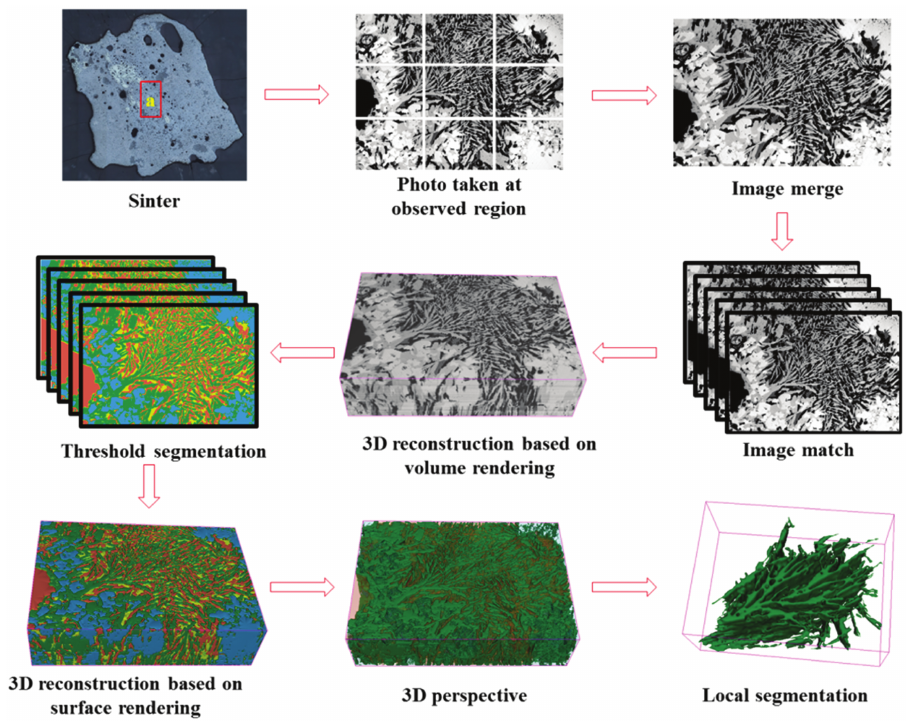
Figure 1: Flow chart of serial sectioning and 3D reconstruction